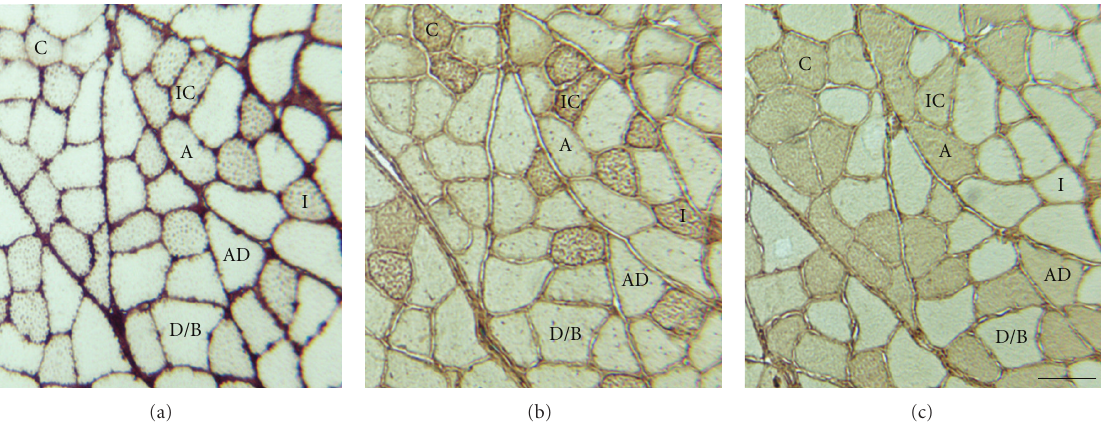
Figure 1: Immunohistochemical analysis of the plantaris. Micrographs representative of immunohistochemical assays for (a) HSP70, (b) MHC I, and (c) MHC II (Bar = 100 µ m).